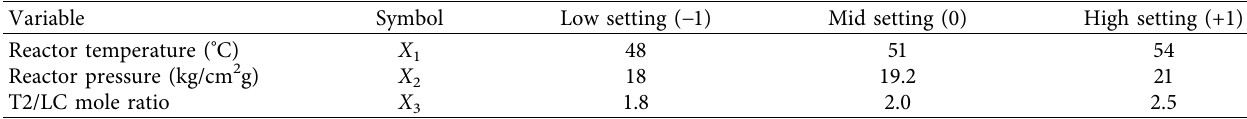
Table 2: Factor to optimize the PPC.